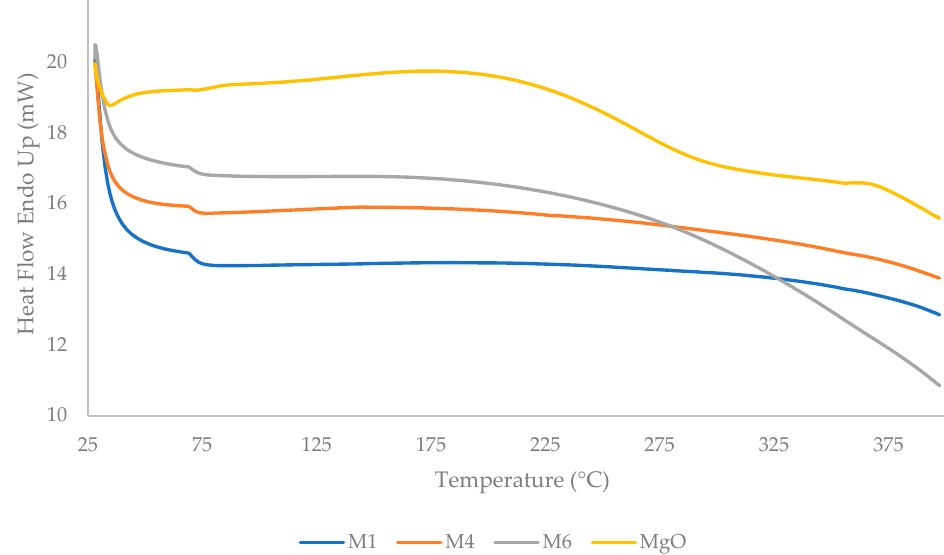
Figure 6. Differential scanning calorimetry (DSC) thermogram of MgO nanosheet powder, PDMS, and PDMS/MgO membranes.